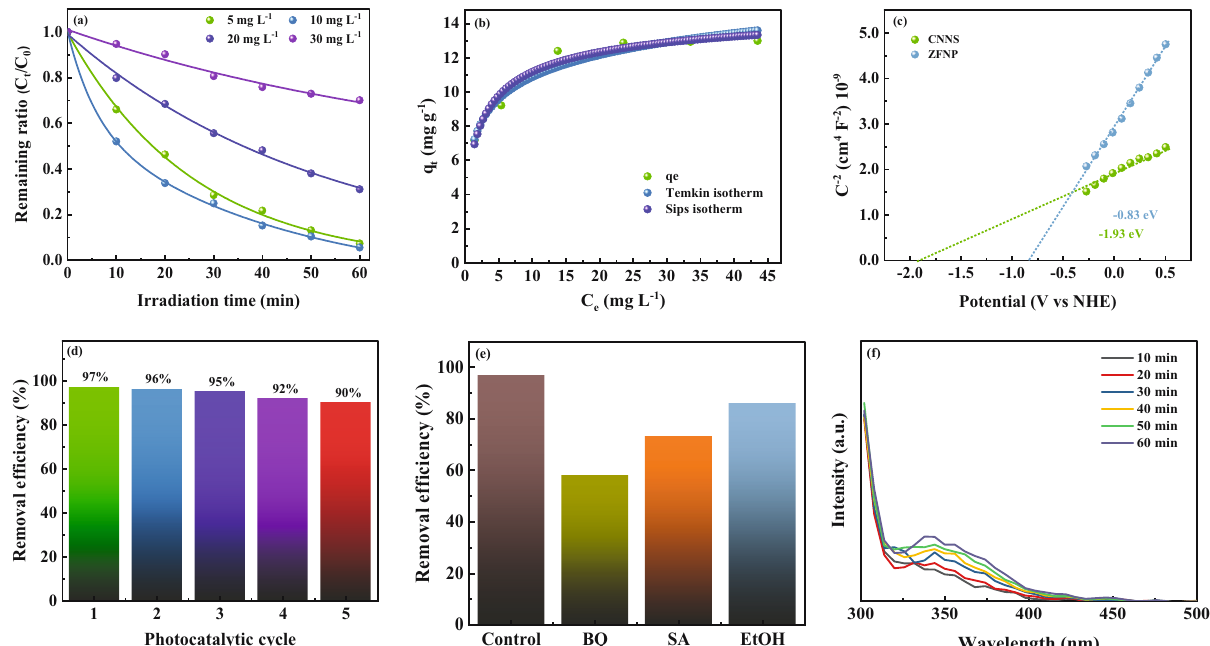
Figure 4: ( a ) The photocatalytic activity of the ZFNP – CNNS nanocomposite, ( b ) the exponential fi tting of the Sips and Temkin isotherms, ( c ) Mott – Schottky plot, ( d ) the recyclability performance of the ZFNP – CNNS nanocomposite, and ( e ) the trapping experiment for reactive oxygen species ( ROS ) , and ( f ) H 2 O 2 production photodegradation of